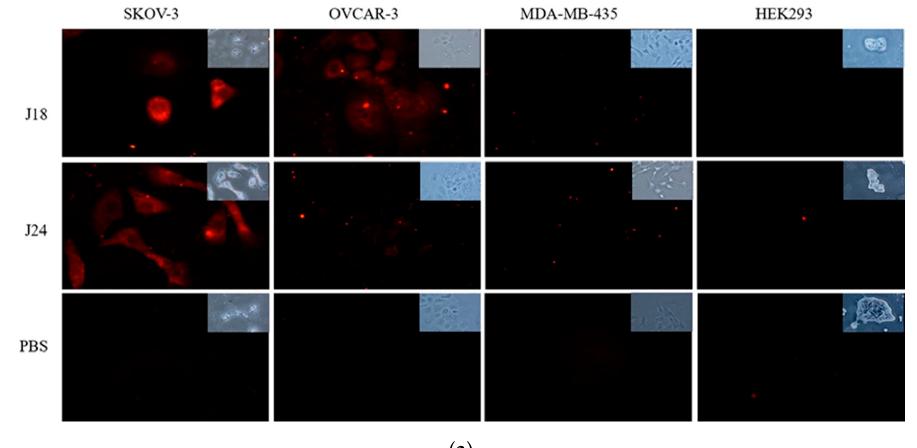
Figure 1. Fluorescent microscopy of phage binding to SKOV 3 cells. ( a ) Cells were incubated with 10 11 V/mL pJ18, pJ24, wild type (WT), or dimethyl sulfoxide (DMSO) (vehicle) and probed by